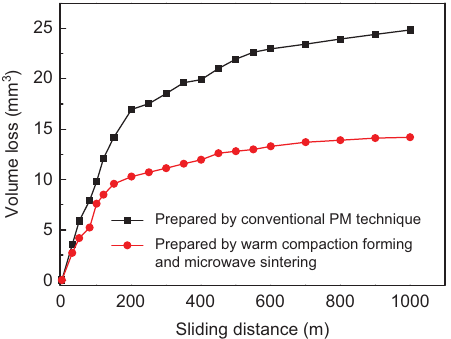
Figure 3 Volume loss vs. sliding distance of TiC/316L composite at 100 N.